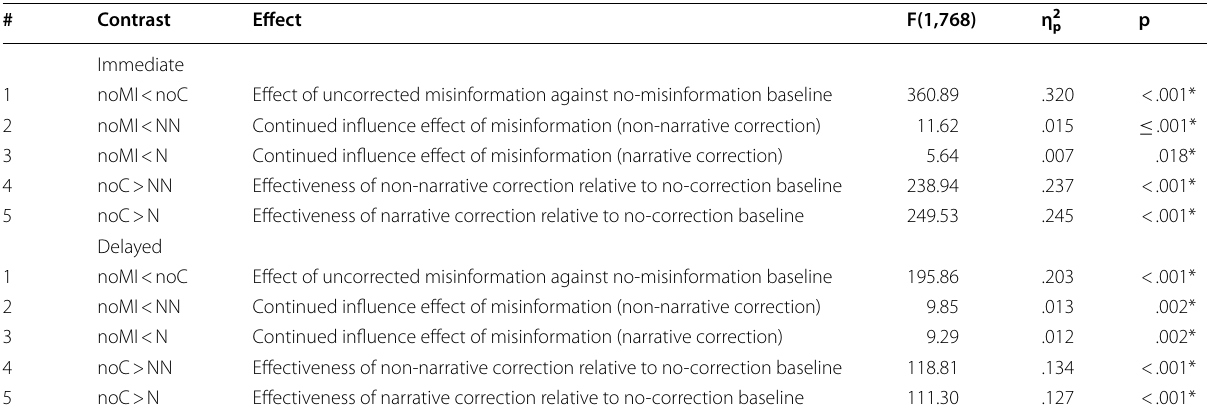
Table 2 Secondary contrasts run in Experiment 1